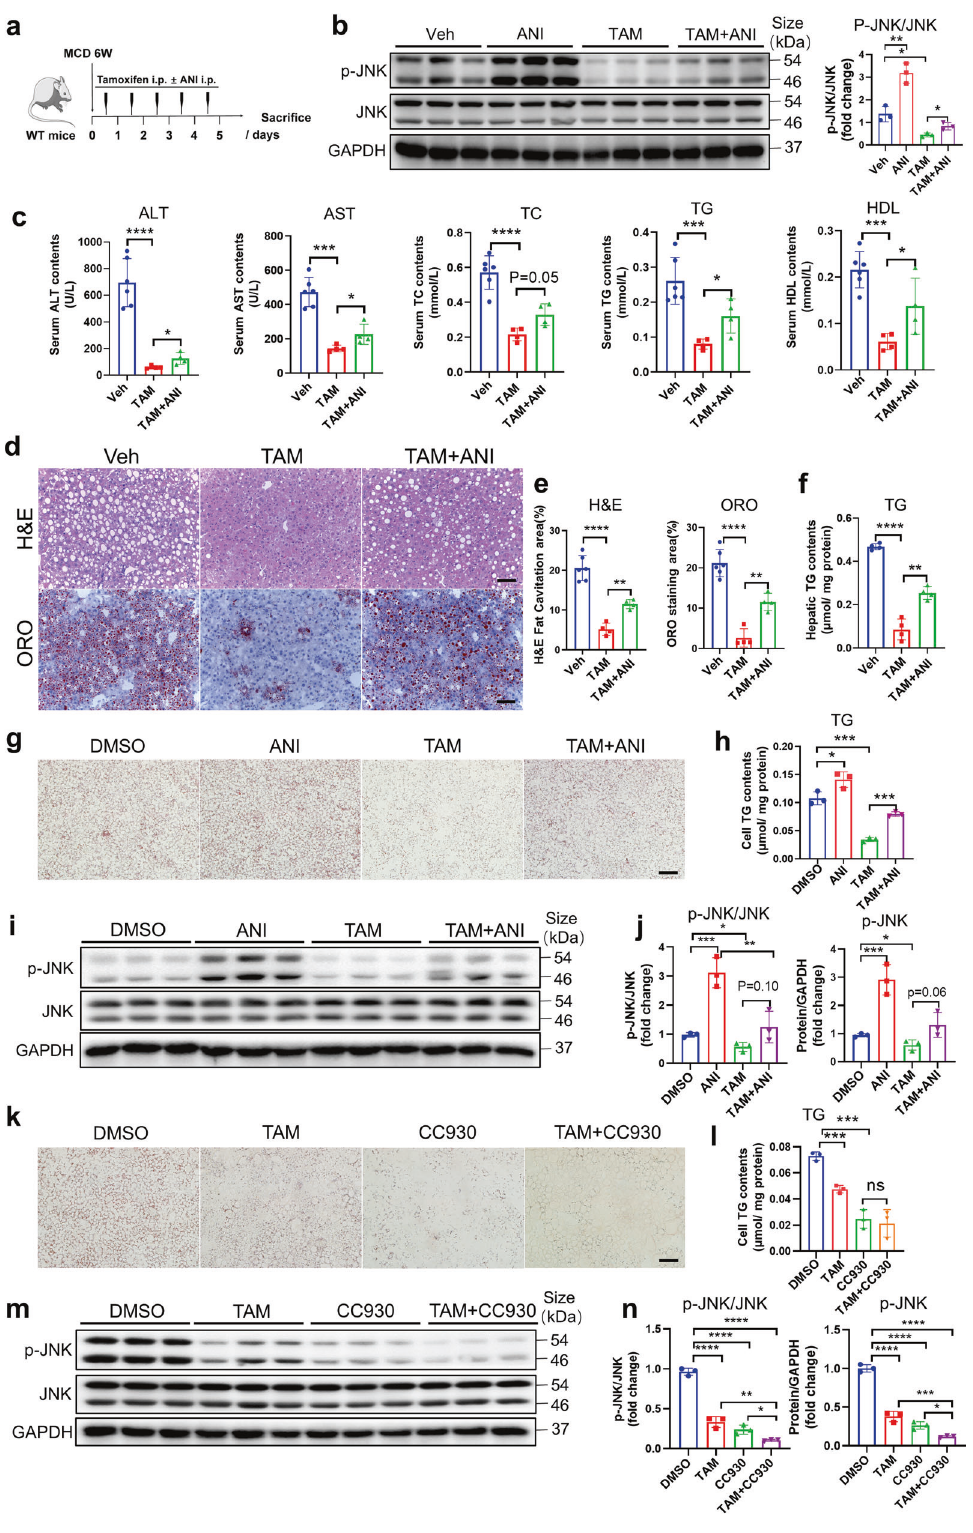
Gene expression pro fi ling